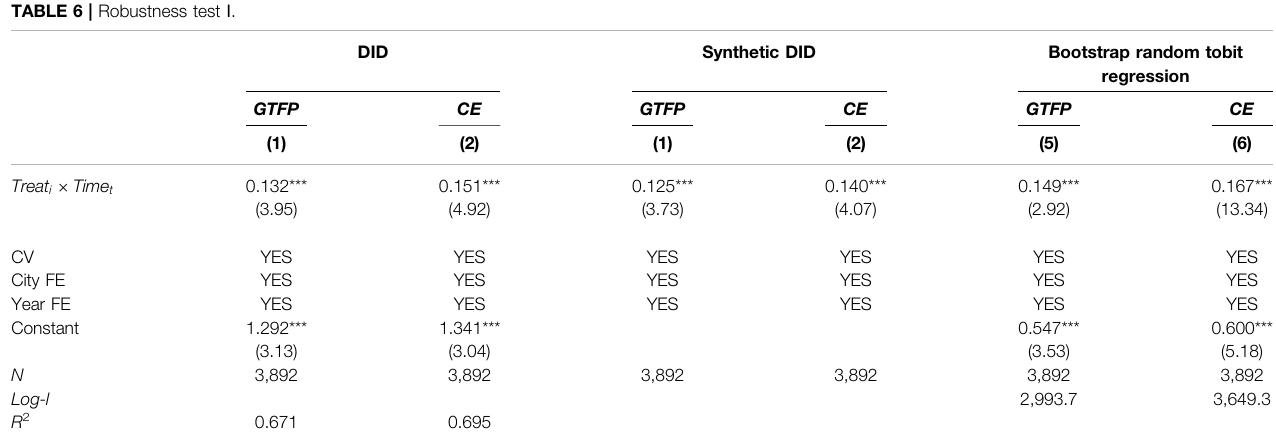
TABLE 6 | Robustness test Ⅰ